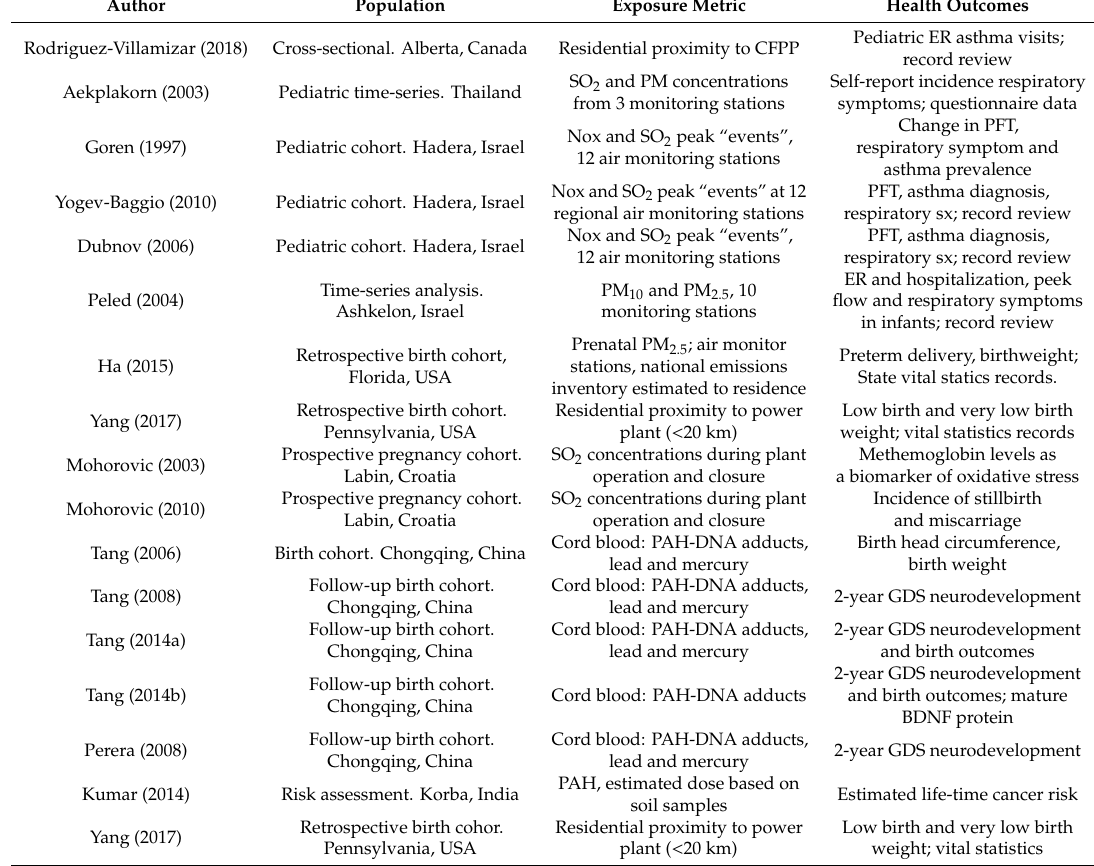
Table 2. Summary of study population, exposure, and outcome